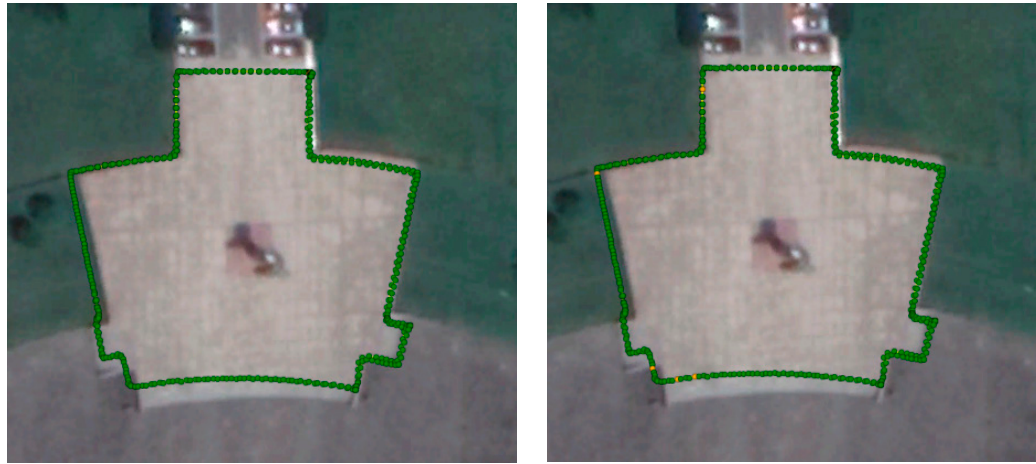
Figure 15. Kinematic positioning trajectory with a 5.2-km and 9.6-km baseline distance to the VRS.